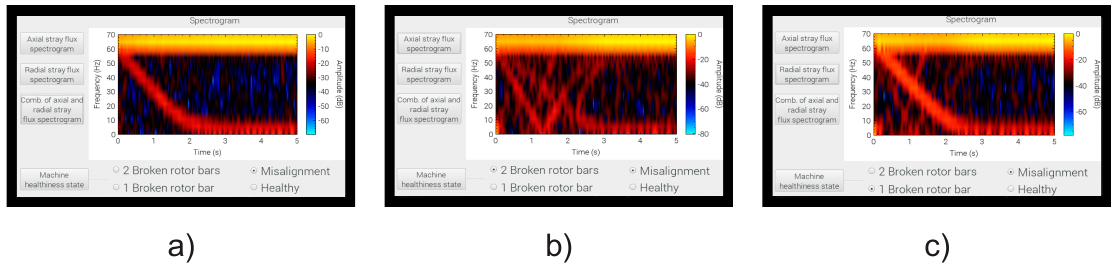
Figure 15. Visualization of the main menu of the smart–sensor.